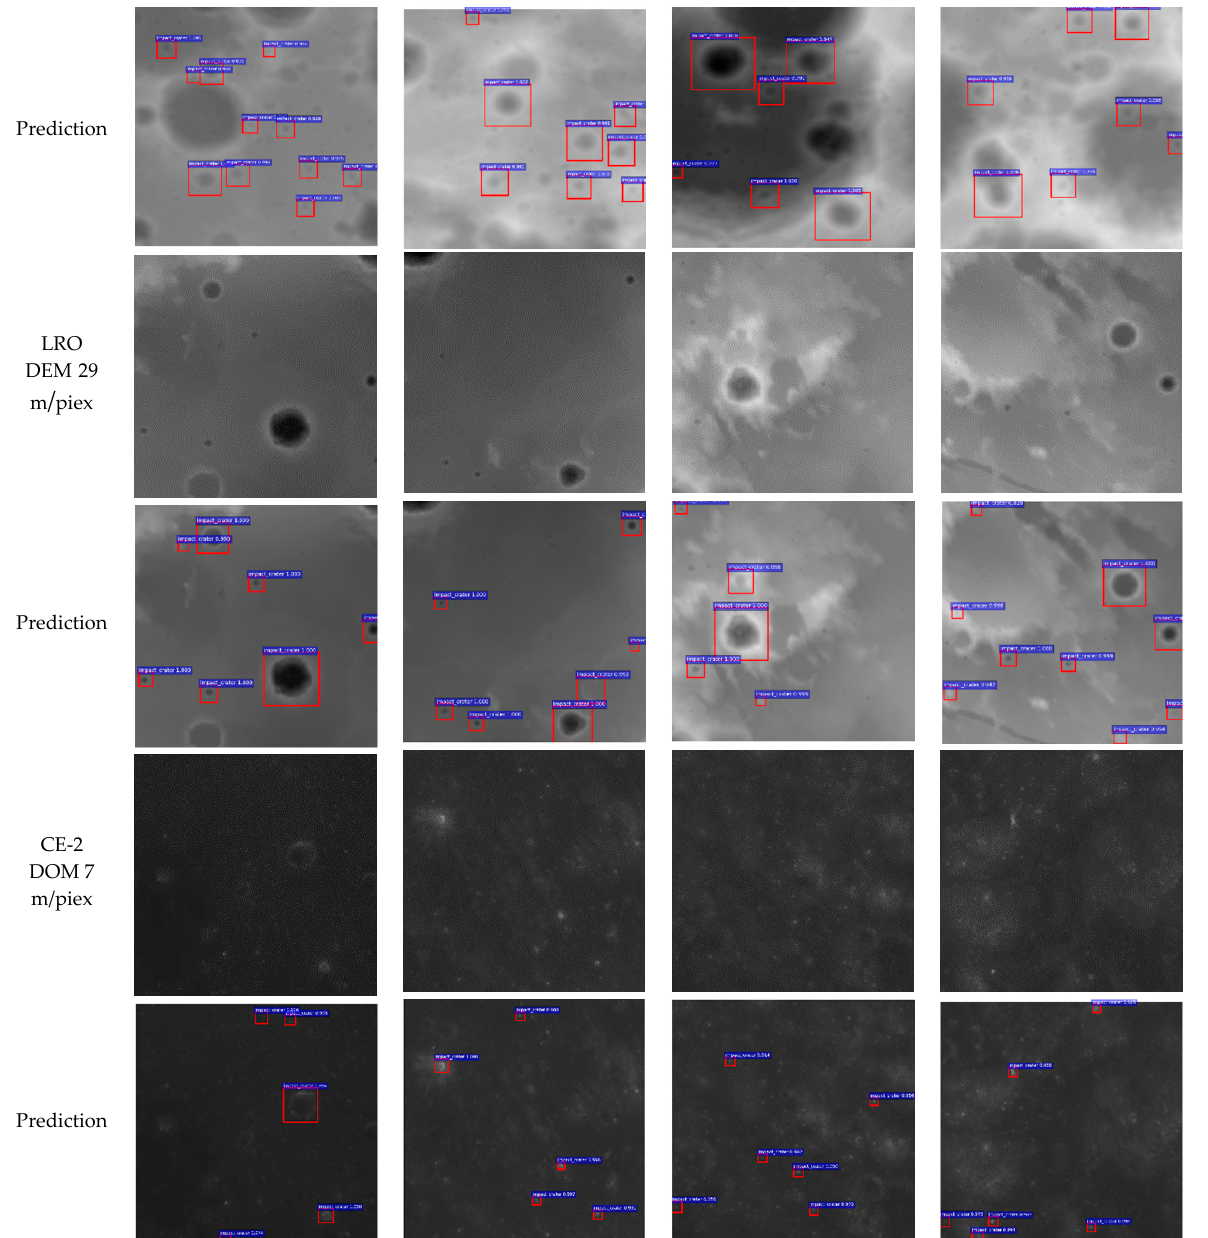
Figure 13. Crater detection results for data with different resolutions.